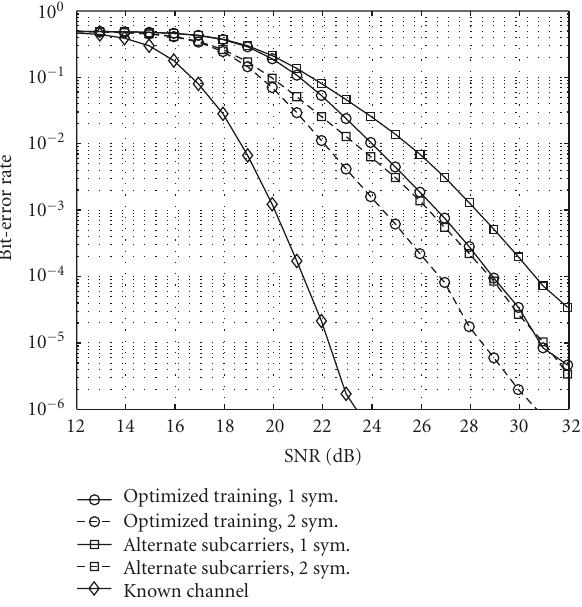
Figure 9: BER versus SNR for a 3 × 3 OFDM system: 16-QAM, rate-3/4 convolutional code, IEEE 802.11n channel model